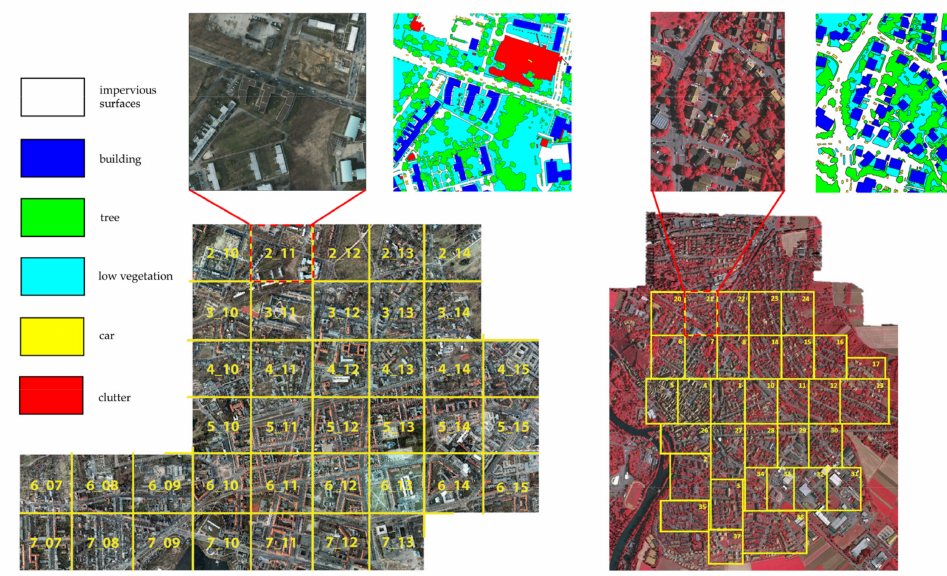
Figure 4. The overall view of ISPRS 2D semantic benchmark datasets. (From left to right ) Columns show the images of the Potsdam dataset and images of the Vahingen